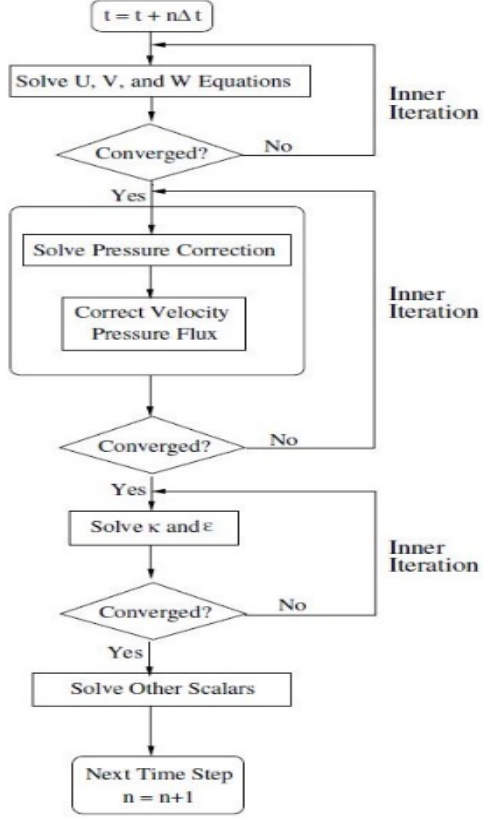
Figure 11. Noniterative time advancement method chart.